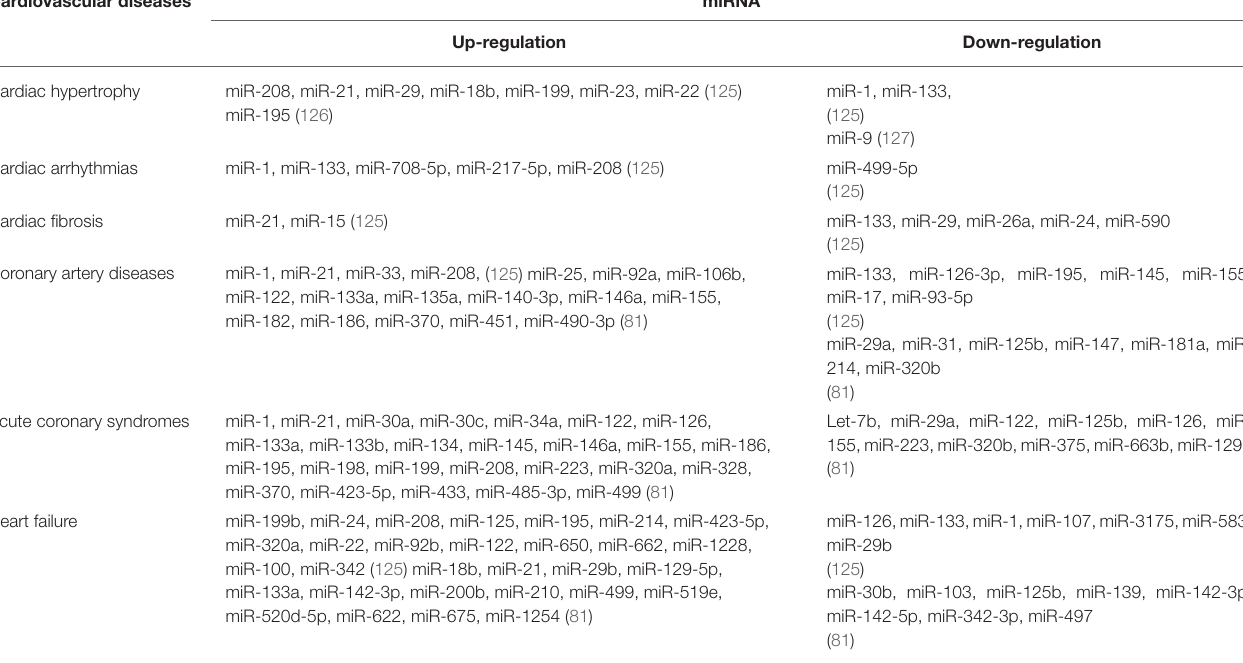
TABLE 2 | The regulation of miRNA in different CVDs. Cardiovascular